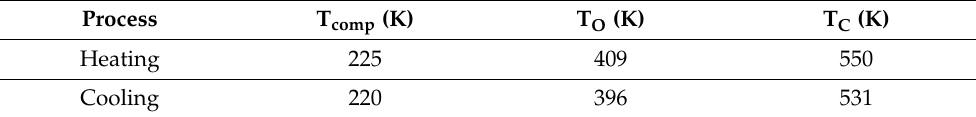
Table 3. Characteristic magnetic temperatures of